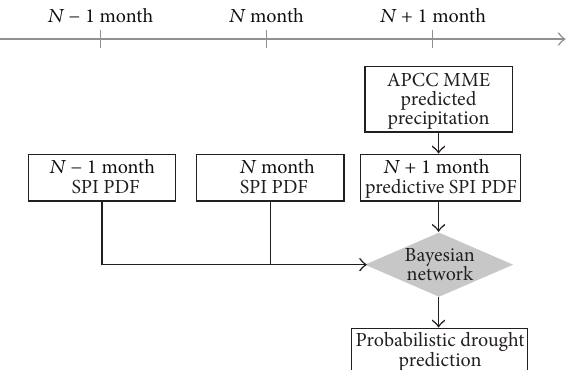
Figure 2: Schematic diagram of the Bayesian network-based drought forecasting.